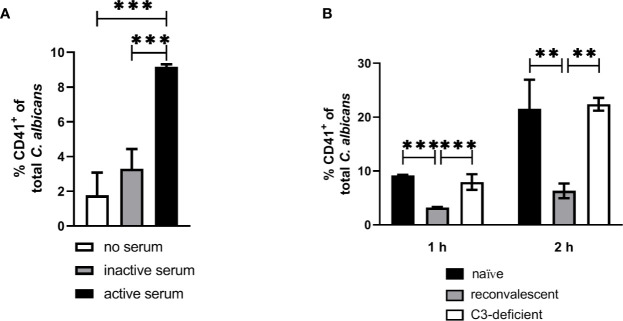
Interaction of isolated murine platelets with C. albicans. (A) Binding of isolated platelets to C. albicans cells in the presence of heat-inactivated serum (inactive serum) or non-treated serum (active serum). The percentage of CD41-positive C. albicans cells was determined after 1 h by flow cytometry. Active serum led to a significantly higher interaction with platelets compared inactive serum and a control without serum (asterisks indicate significant differences (p<0.05) determined by 1-Way ANOVA and Holm-Sidak’s multiple comparison test for pairwise comparisons of all groups). (B) Binding of isolated platelets to C. albicans cells in the presence of active serum from naïve mice, serum of mice collected after infection with C. albicans (reconvalescent) and serum from naïve C3-deficient mice analyzed after 1 h and 2 h. Reconvalescent serum led to significantly lower binding (significance determined by 1-Way ANOVA and Holm-Sidak’s multiple comparison test for pairwise comparisons of all groups within one time point and indicated by asterisks).